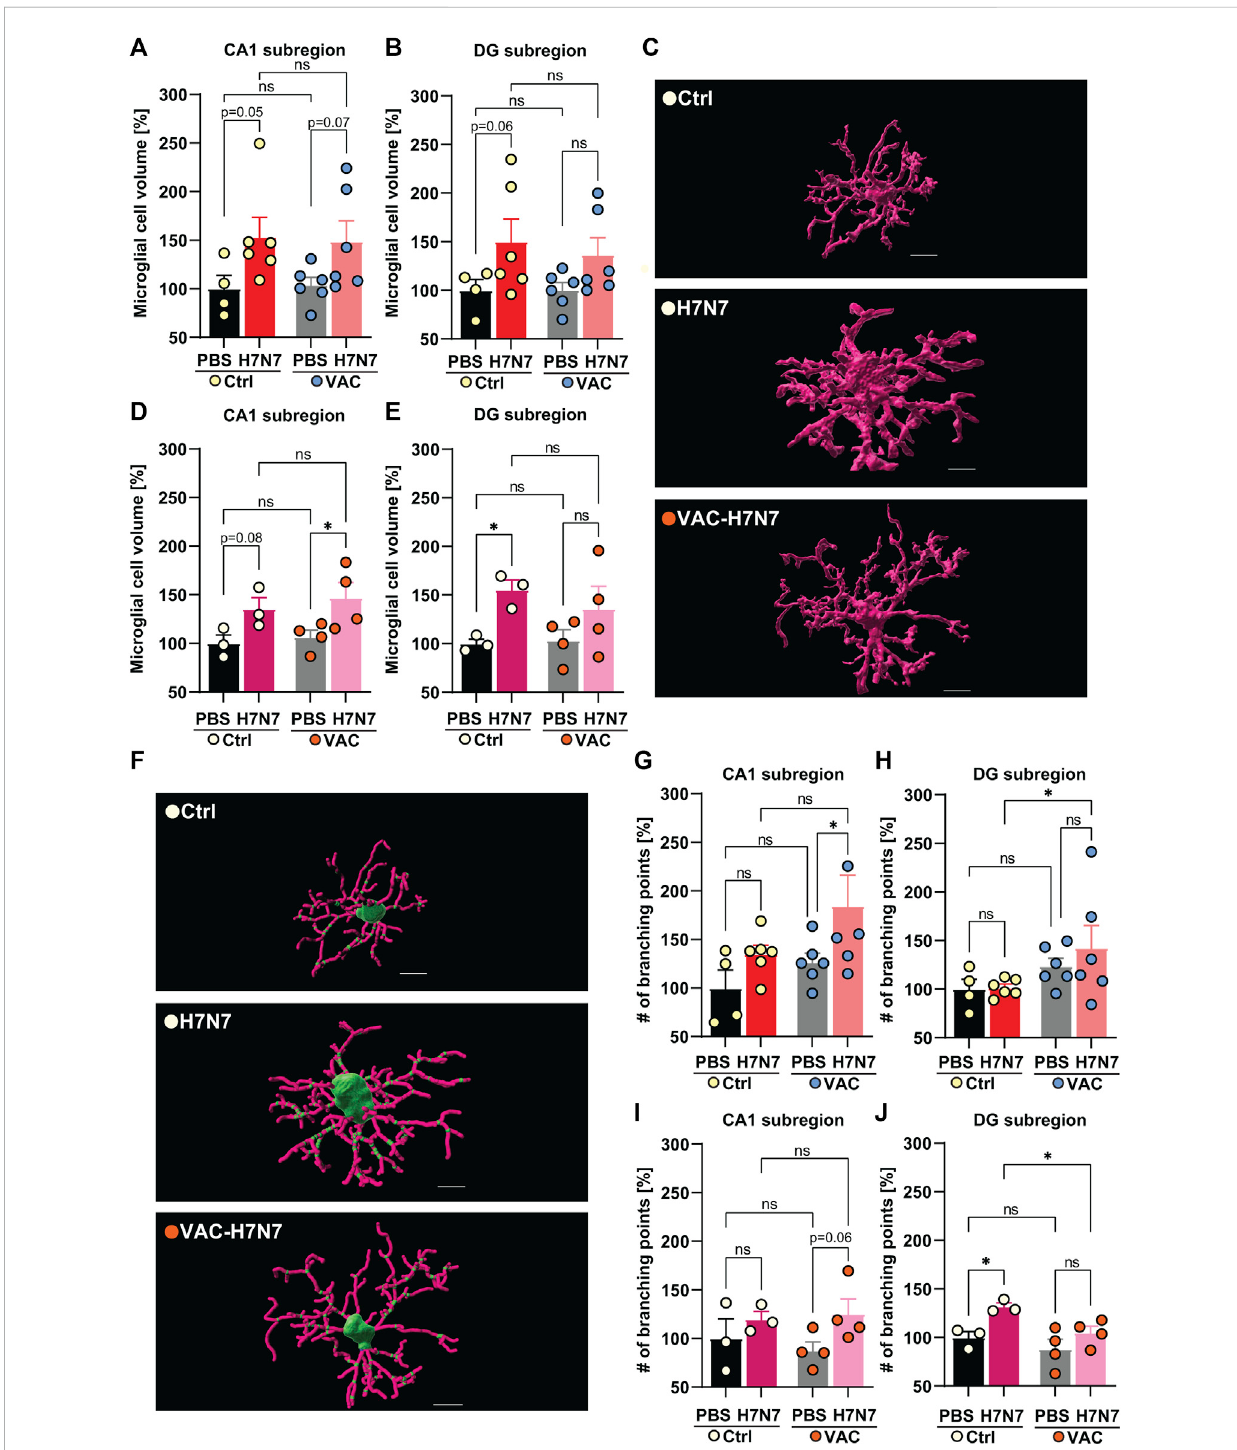
FIGURE 5 Effects of vaccination on microglial morphological changes induced by H7N7 IAV infection. In young mice (A) microglial cell volume in the CA1subregion ofthehippocampuswasincreased8 daysafterinfectionwiththeH7N7IAVinbothunvaccinated andvaccinatedmicecomparedwiththe corresponding control groups receiving PBS ( n = 4 – 6 animals per group). (B) Infection with the H7N7 IAV resulted in an increase in the volume of microglialcellsinthe dentategyrus subregioninunvaccinatedmicecomparedwiththecontrolgroup.Thisincreasewasseentoalesserextentafter infection with the H7N7 IAV in previously vaccinated mice. Vaccination itself did not signi fi cantly increase microglial cell volume in either subregion ( n = 4 – 6 animals per group). (C) Representative 3D reconstruction of a microglial cell volume in the dentate gyrus subregion of unvaccinated and vaccinated older animals after infection compared with PBS inoculation; scale = 7 μ m. In aged mice, at 10 days after H7N7 IAV infection, microglial cell volume increased in (D) CA1 and (E) DG subregions compared with unvaccinated PBS-inoculated mice. Microglial cell volume was signi fi cantly increased in the CA1 subregion of vaccinated mice infected with H7N7 IAV compared with vaccinated mice receiving PBS. Vaccination itself did not signi fi cantly alter